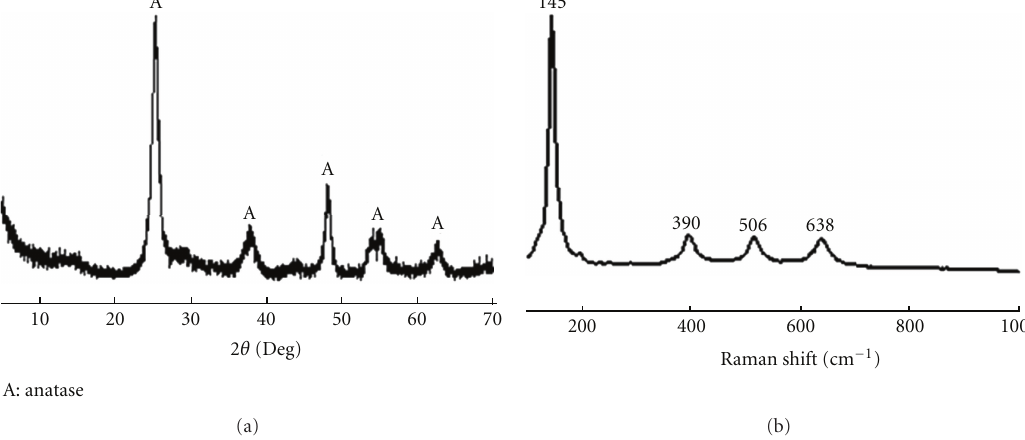
Figure 1: X-ray di ff raction pattern (a) and Raman spectra (b) of TNT powders calcined for 30min at 723K in O 2 atmosphere.